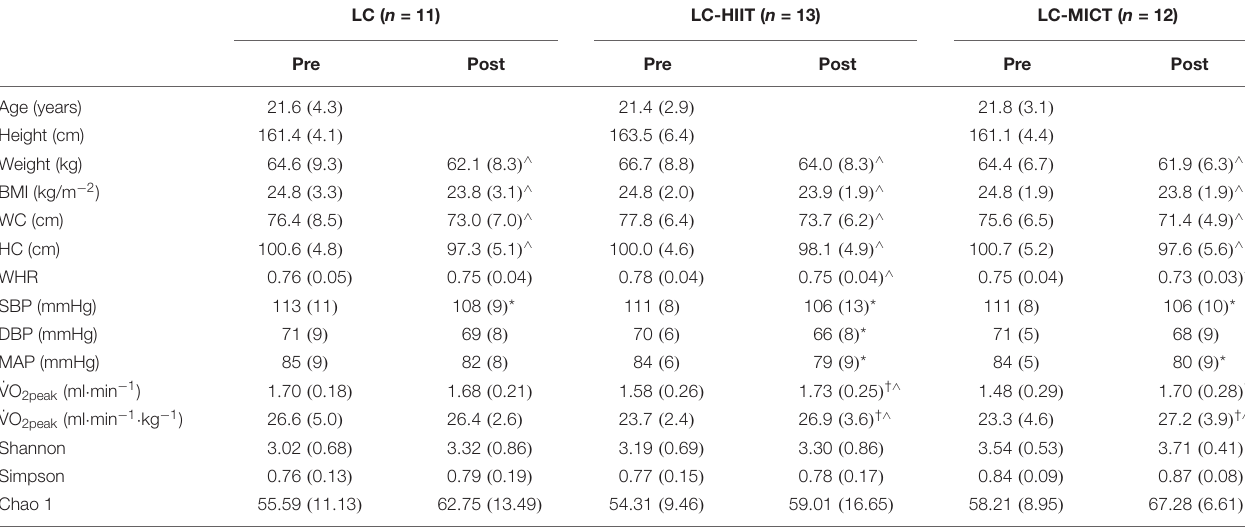
TABLE 1 | Main outcome variables before and after LC with/without training (the cardiometabolic outcomes are published